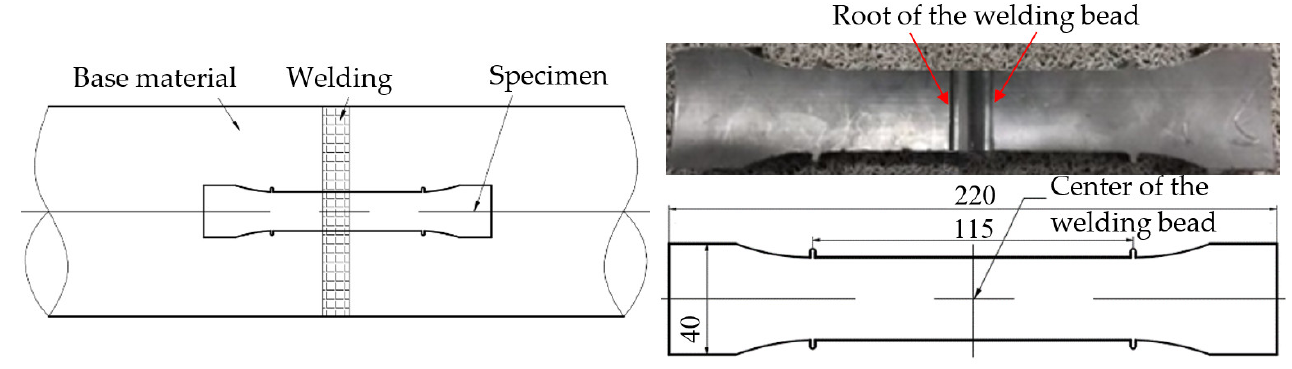
Figure 3. Processing method and dimensions of the creep specimen.